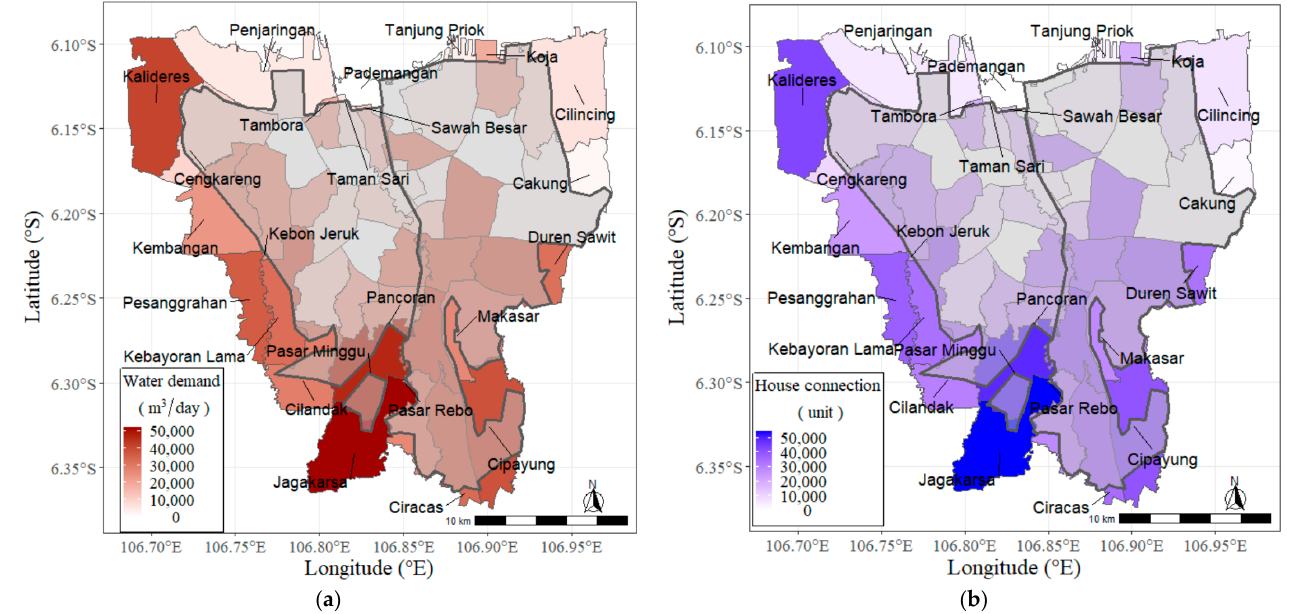
Figure 10. ( a ) Water demand of the non-connected population per district. ( b ) Number of piped water connections to be developed in each district.